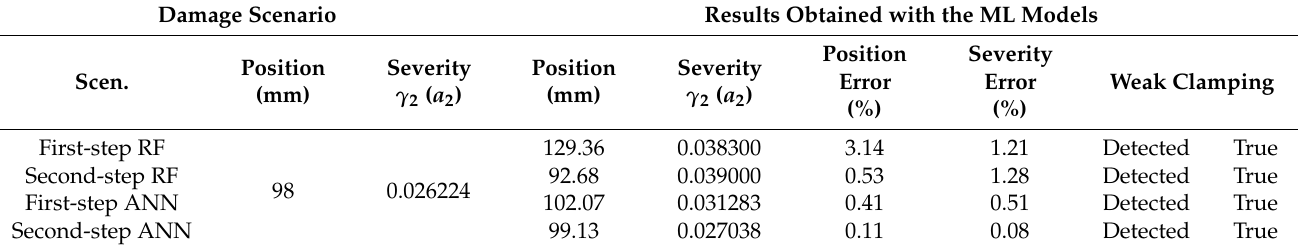
Table 18. Crack assessment for a damaged beam with non-ideal clamping for the case the undamaged beam had initially an ideal fixing (case 1i).